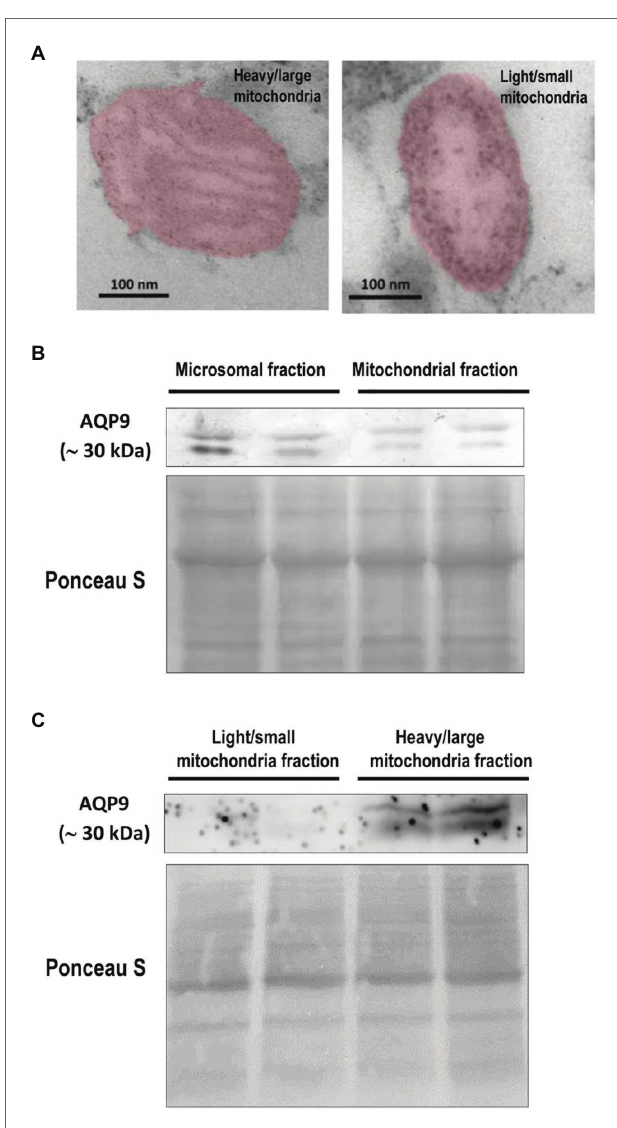
FIGURE 4 | Expression of AQP9 in trophoblast mitochondria. (A) Representative transmission electron microscope images of heavy/large and light/small mitochondria found in the isolated subpopulations. Individual mitochondria were falsely colored to aid in identification. The scale bar represents 100 nm and the magnification is 50,000 × ( n = 4 placentas). (B) AQP9 expression in microsomal and mitochondrial fractions. Representative immunoblot revealed that AQP9 is expressed in both mitochondrial and microsomal fractions isolated from villous trophoblast cells. (C) AQP9 expression in heavy/large mitochondria subpopulation. Representative immunoblot showed the expression of AQP9 only in the heavy/large fraction ( n = 12